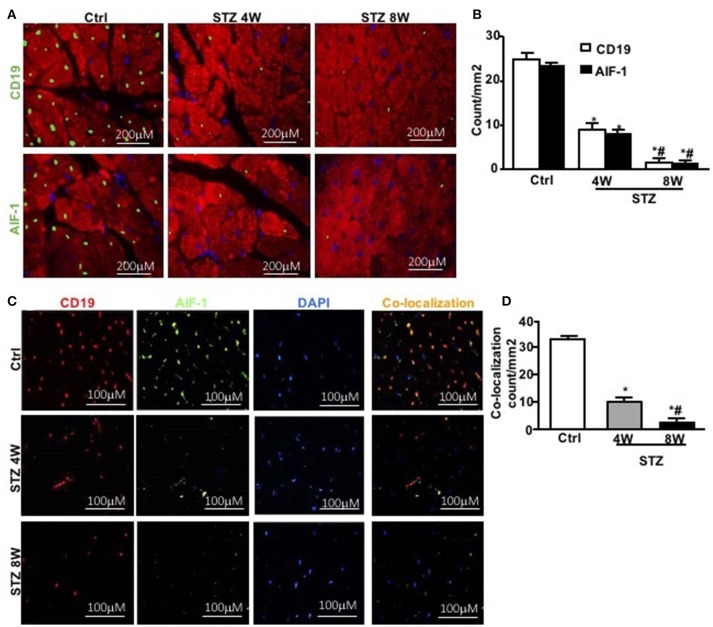
Diabetes induction decreased AIF-1 interaction with B cells in heart mice heart. (A,B) Presence of CD19 (first row) and AIF-1 (second row) positive cells in control mice hearts and downregulation of CD19-positive cells as well as AIF-1-positive cells in diabetic mice hearts were observed as compared to control. alpha-actinin antibody was used to show the cardiomyocytes in the image. CD19 and AIF-1 antibodies (green), alpha-actinin antibody (red), DAPI (blue). (C) Immunofluorescence analysis for co-localization of CD19 and AIF-1 in mice heart. (D) Co-localization quantification. Data are expressed in mean ± SEM (*p < 0.05 as biological significant level, Ctrl vs. STZ), n = 6. #p < 0.05 as biological significance level, STZ 4W vs STZ 8W.